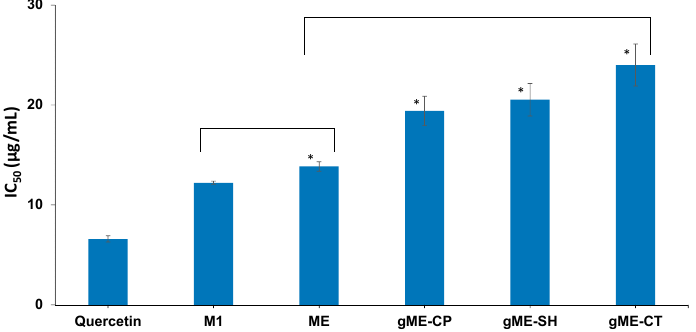
Figure 4. IC 50 values of CURC encapsulated in microemulsion, gel microemulsions systems, and reference solvent mixtures (sample denoted in Table 1). (*) statisticaly significant ( p < 0.05).